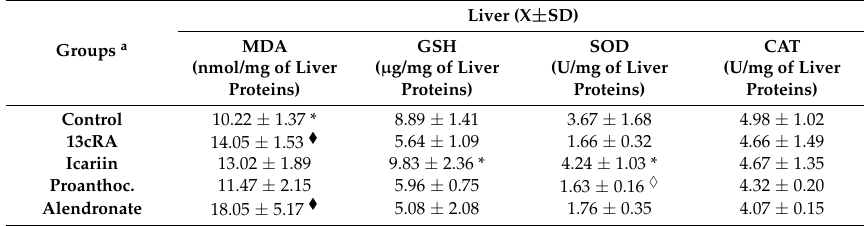
Table 7. Effect of icariin, proanthocyanidins or alendronate on liver malondialdehyde (MDA) and glutathione (GSH) level and superoxide dismutase (SOD), and catalase (CAT) activities in rats with retinoic acid-induced bone loss.